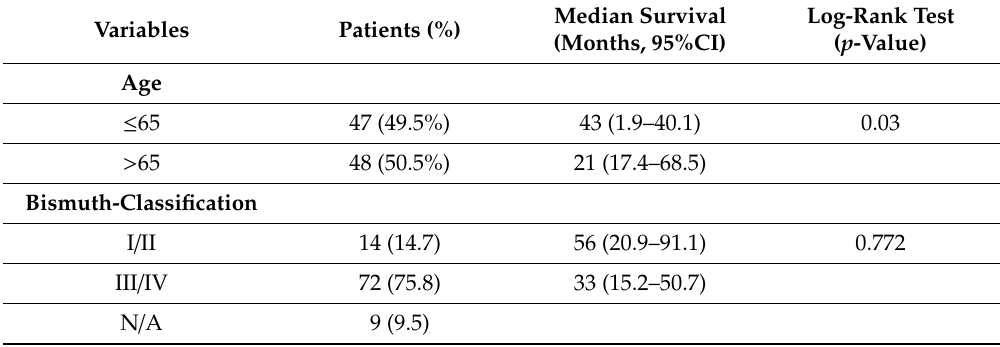
Table 4. Univariate Kaplan-Meier survival analysis of the study population ( n = 95